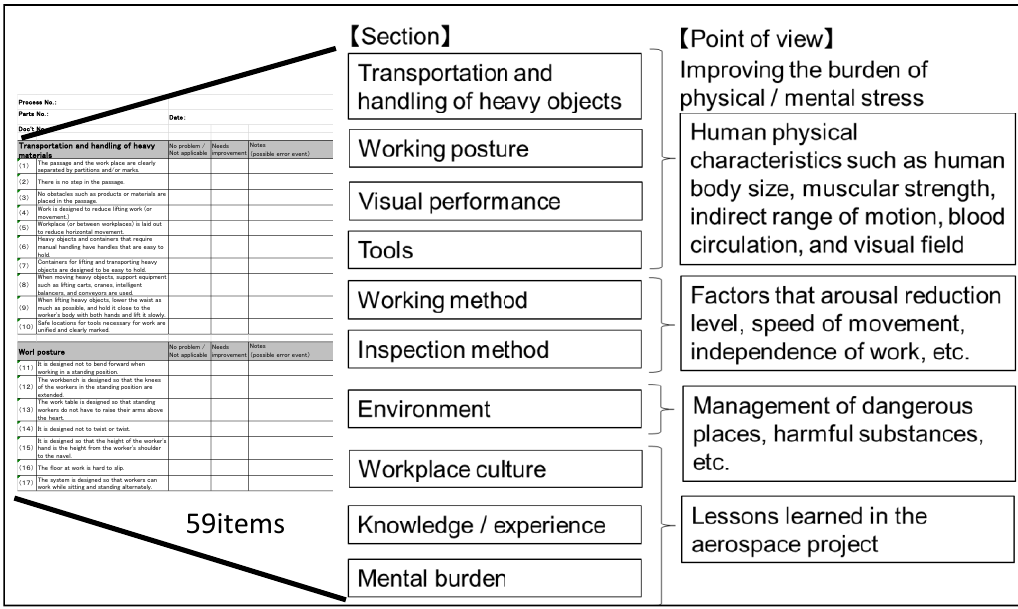
Figure 2. The outline of the check